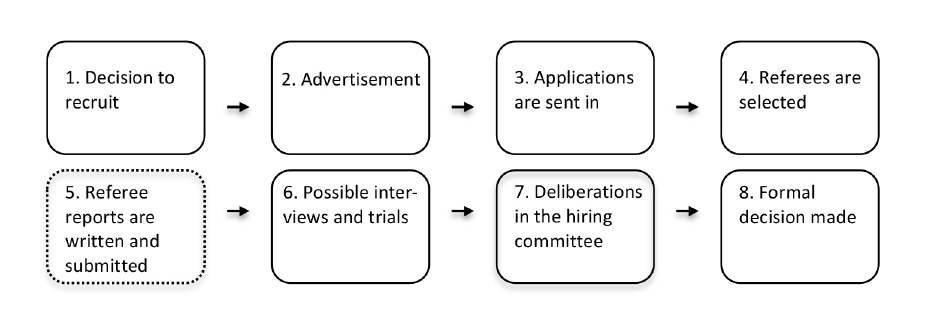
Figure 1 Schematic overview of the hiring process Source: Authors'